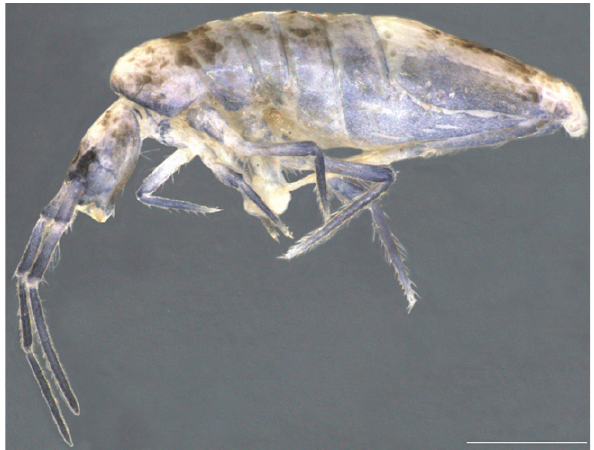
Figure 1. Seira caerucinerea sp. nov. : habitus of a specimen in etha- nol. Scale bar: 0.5